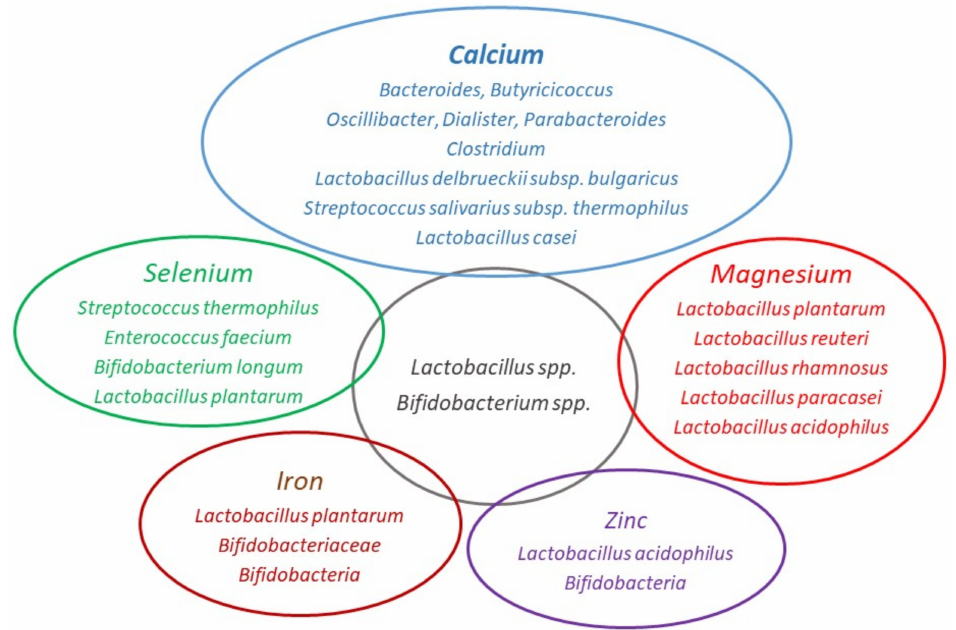
Figure 1. Bacterial strains related to mineral bioaccessibility and bioavailability. Image created according to Whisner et al. [19,20]; Amdekar et al. [21]; Aljewicz et al. [22]; Bergillos-Meca et al. [23]; Skrypnik and Suliburska [24]; Lidbeck et al. [25]; Massot- Cladera et al. [26]; Krausova et al. [27]; Malyar et al. [28] and Zhou et al.